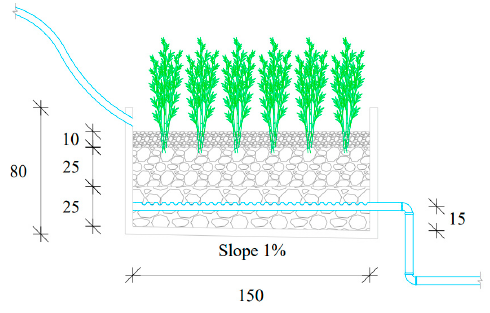
Figure 2. Reed bed filtration